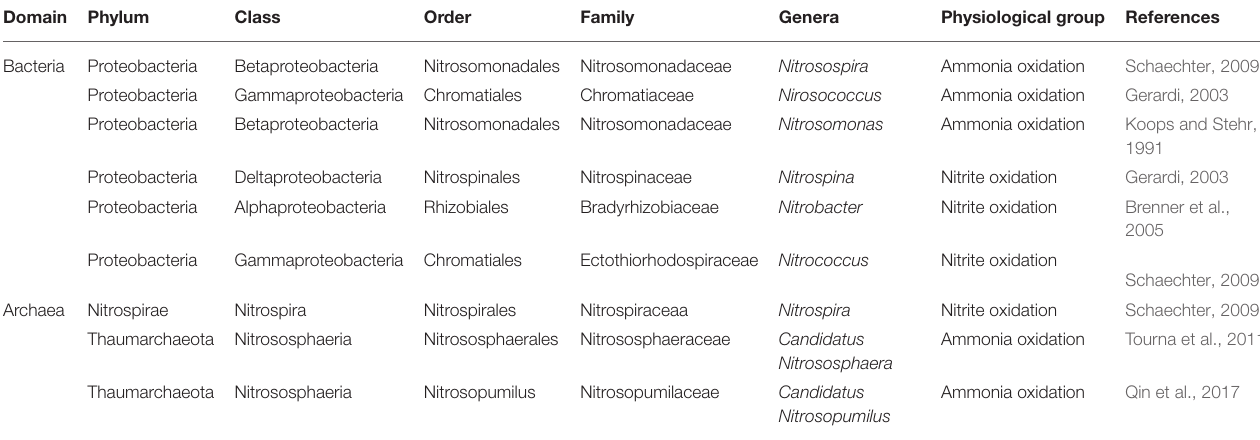
TABLE 3 | Well-identified nitrifying bacteria and archaea genera and their physiological